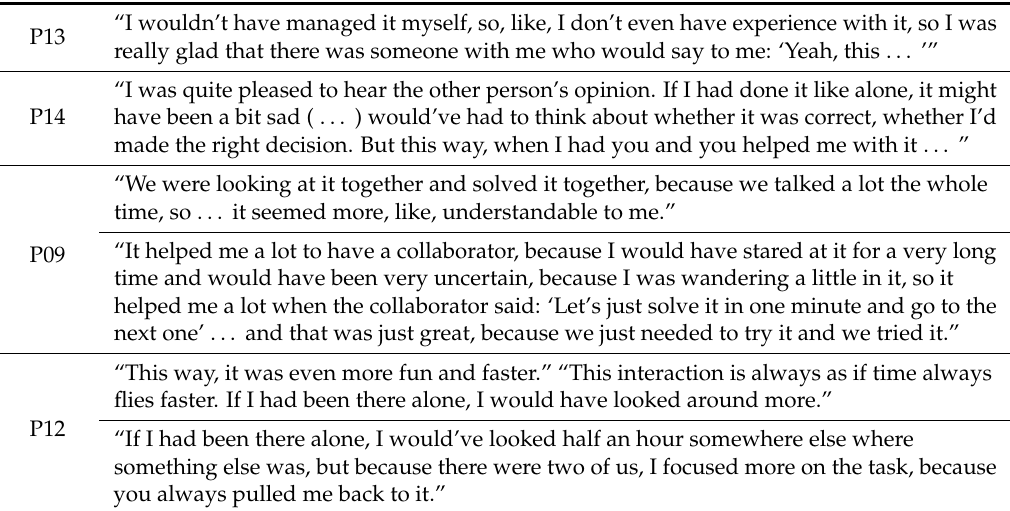
Table 1. Verbatim excerpts of statements by participants: Lost without a